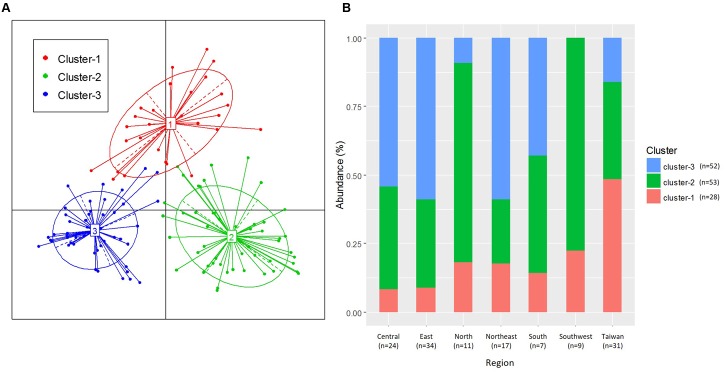
Clustering of breast milk samples from 133 mothers, based on bacterial family composition data. (A) Jensen–Shannon divergence and Partitioning Around Medoids (PAM) clustering were used. The optimal number of clusters was chosen by maximizing the Calinski–Harabasz index and was validated on the basis of the prediction strength and average silhouette width indices. (B) Ratio of the three clusters in each region.